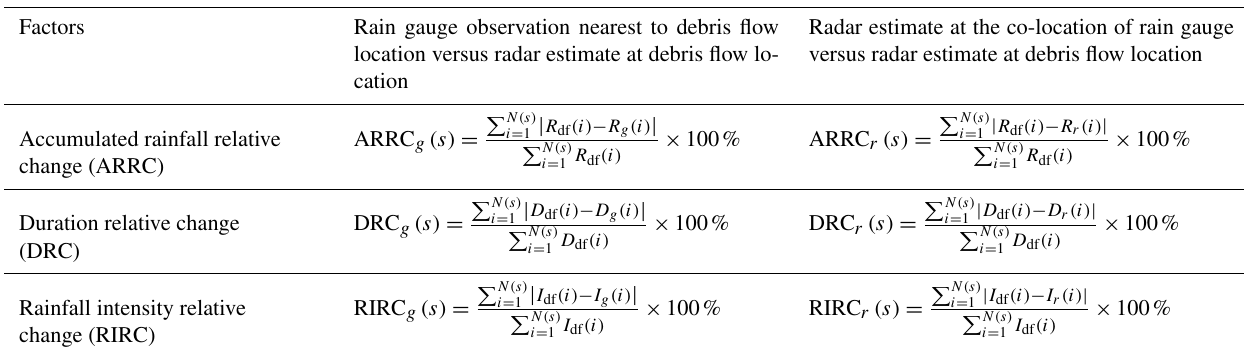
Table 5. The metric for assessing the relative changes of the accumulated rainfall, duration and rainfall intensity versus distance. Radar estimate at the co-location of rain gauge Factors Rain gauge observation nearest to debris flow versus radar estimate at debris flow location location versus radar estimate at debris flow lo- cation